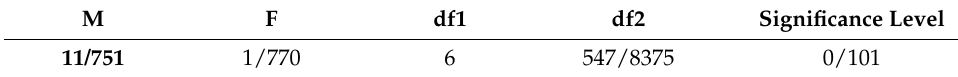
Table 3. Box test for variance–covariance matrix equality.